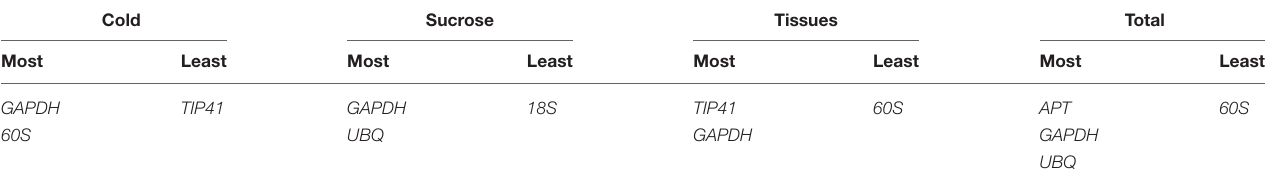
TABLE 3 | Best combination of RGs based on the geNorm and